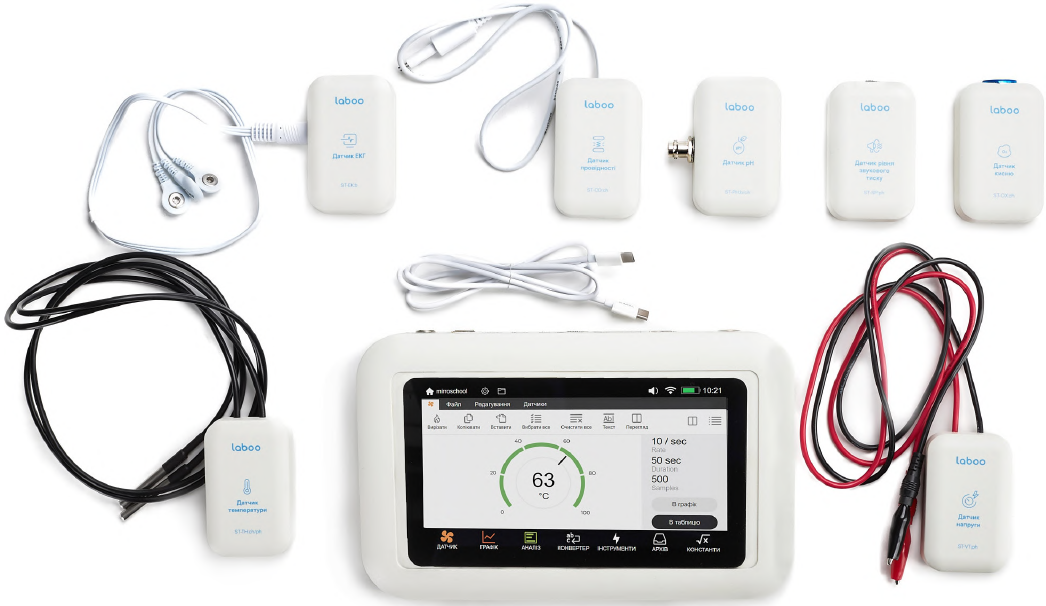
Figure 2: Digital measuring complex Skoolto